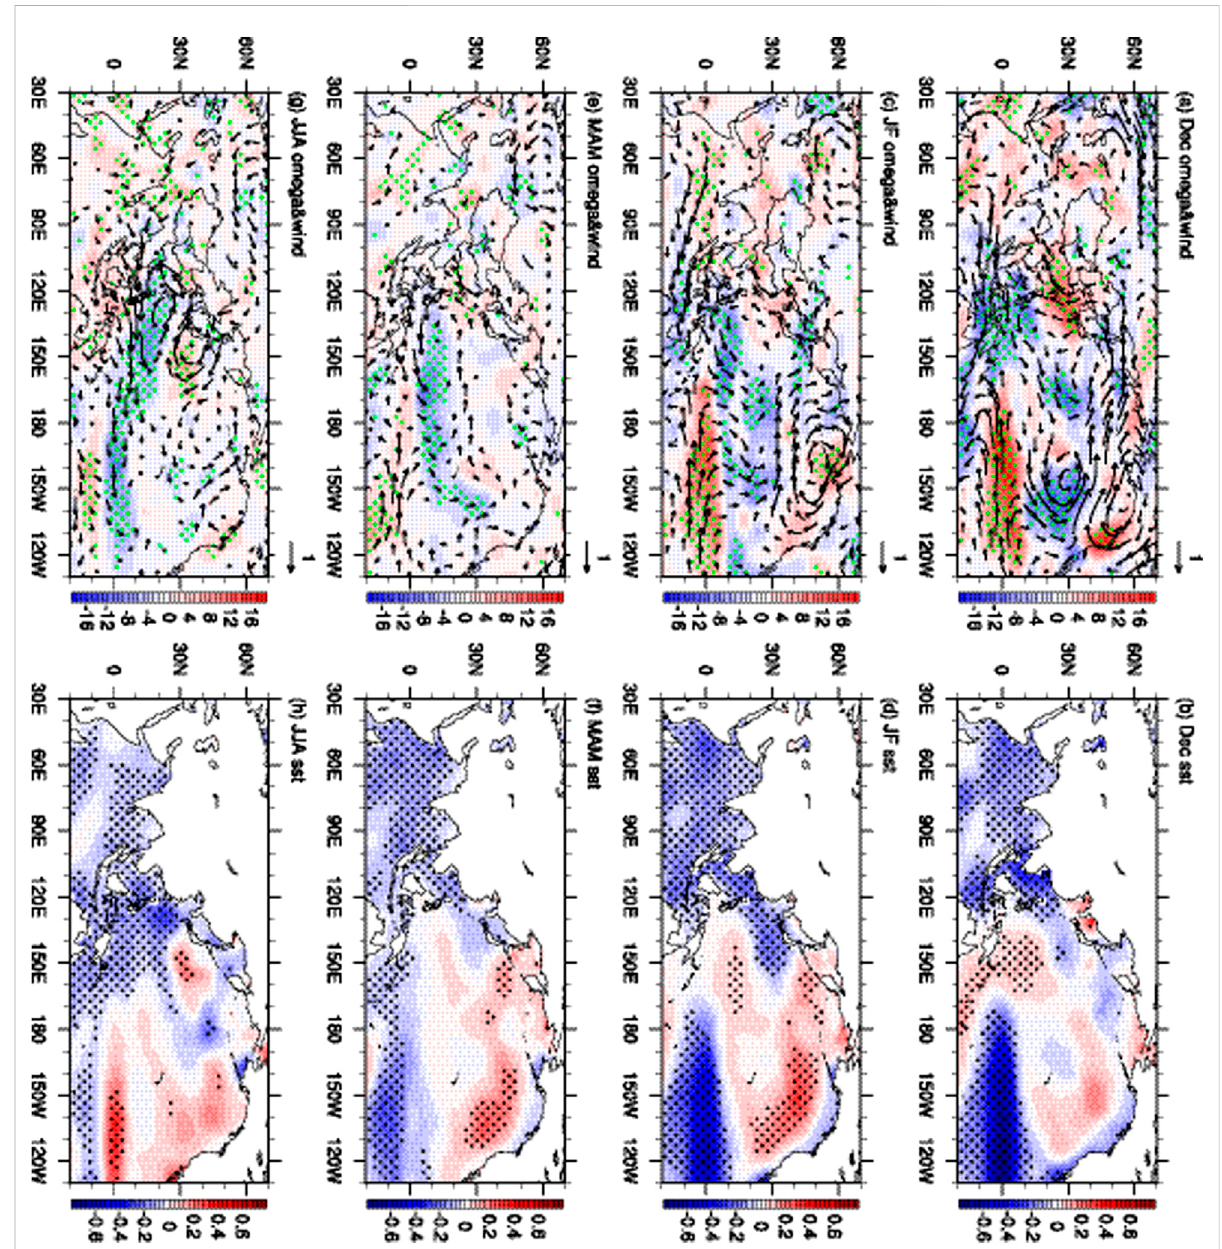
FIGURE 6 Anomalies of (A,C,E,G) the500 hPa verticalvelocity(shading;units:10 – 3 Pa s − 1 )and850 hPa horizontalwind(vector;units:m s − 1 )and (B,D,F,H) the SST (units: K) in the simultaneous (A,B) December, the following (C,D) January − February mean, (E,F) March − April − May mean and (G,H) summer regressedonthetimeseriesofthesign-reversedsoil_Dec.Thedotsdenotetheanomaliessigni fi cantatthe90%con fi dencelevelbasedonStudent ’